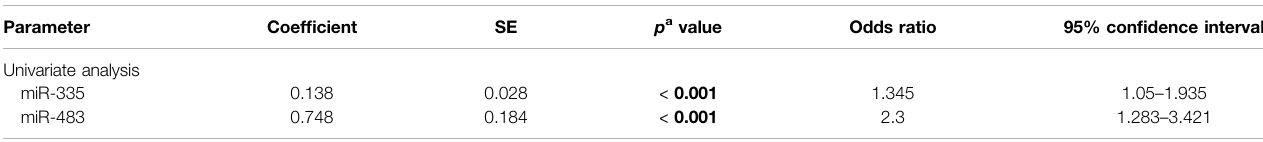
TABLE 4 | Logistic regression analysis to predict the risk of HCC in non -malignant groups.